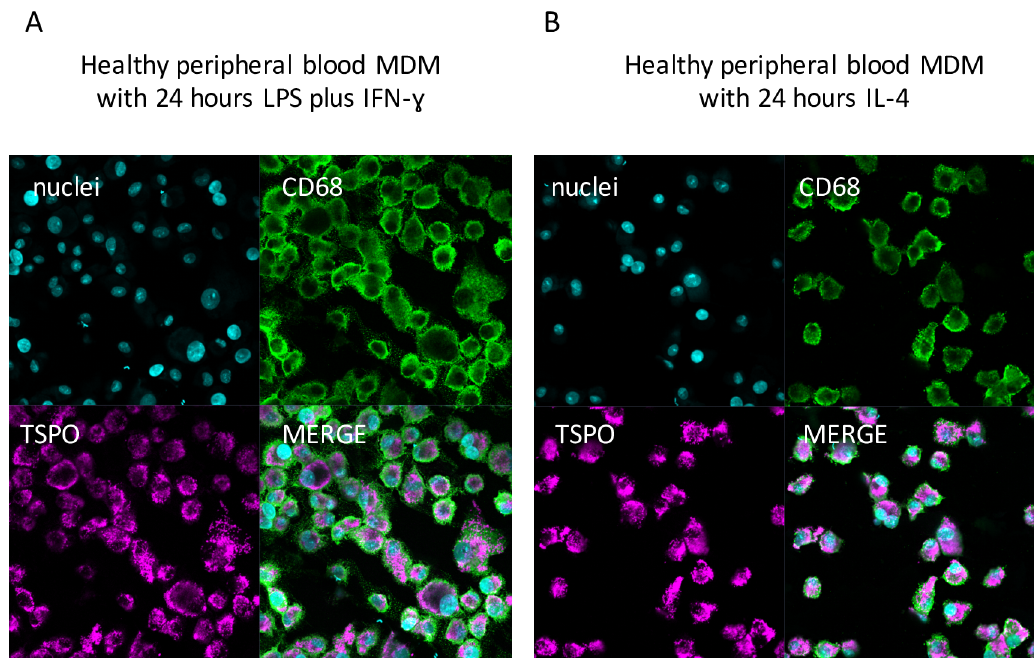
Fig 4. Representative immunofluorescencestaining images of cytospin slides of healthy peripheral blood M1 and M2 MDM. Immunofluorescence stainingof cytospin slides of healthyperipheralblood MDM with the nuclear stain POPO-1 (to confirm presenceof cells), TSPO, the macrophage marker CD68 and merging of the three stains. (A) stainingof MDM stimulatedwith LPS plus IFN - γ for 24 hours; (B) stainingof MDM stimulatedwith IL-4 for 24 hours. x400 magnification. Scale bar = 20 μ